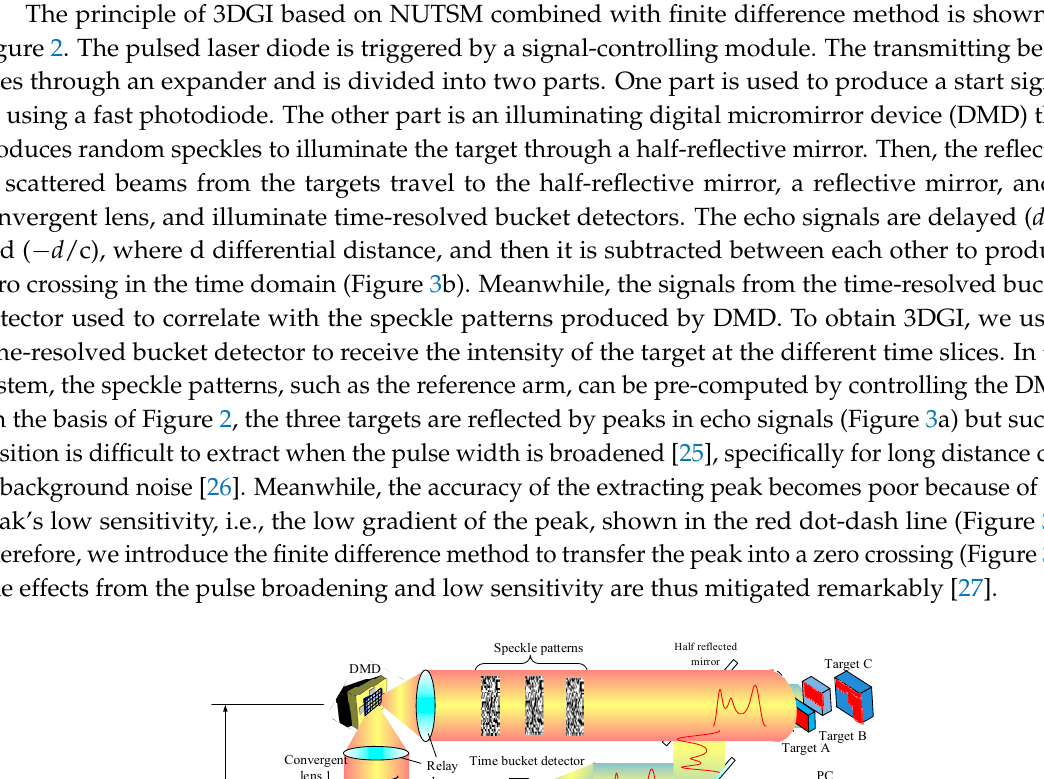
Figure 1. Comparison between uniform and non-uniform time-slice sequences. ( a ) Multiple targets are illuminated by pulsed laser. ( b ) Traditional uniform time-slice method (UTSM), and the interval between neighbor time slices is uniform. ( c ) Non-uniform time-slice method (NUTSM), and time slice are located on peak positions.